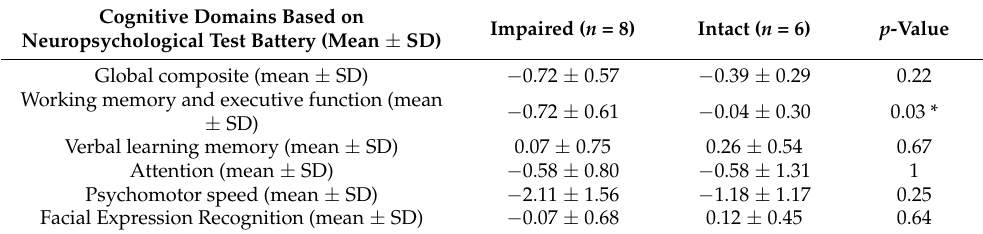
Table 4. Cognitive test results based on neuropsychological